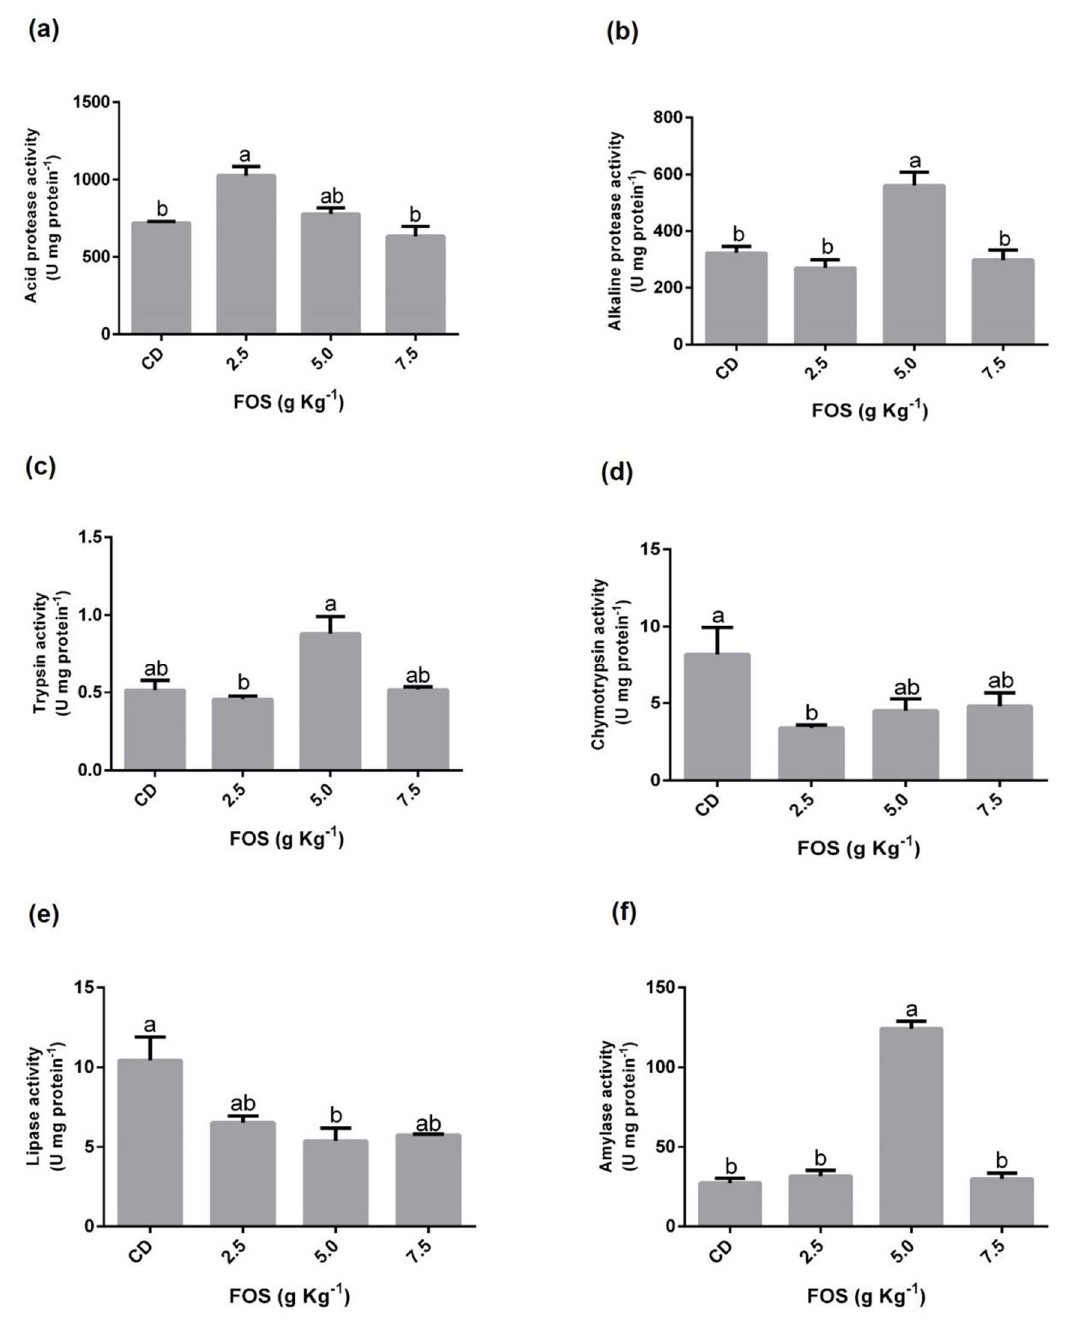
Figure 1. Digestive enzyme activities (U mg protein − 1 ) of A. tropicus larvae (19 DAH) fed a diet supplemented with different levels of FOS (2.5, 5.0, and 7.5 g kg − 1 ) and a diet without FOS (control diet) for 15 days. ( a ) acid protease, ( b ) alkaline protease, ( c ) trypsin, ( d ) chymotrypsin, ( e ) lipase, and ( f ) amylase. Values are mean ± SD. Significant differences between the diets are indicated by different letters ( p < 0.05).